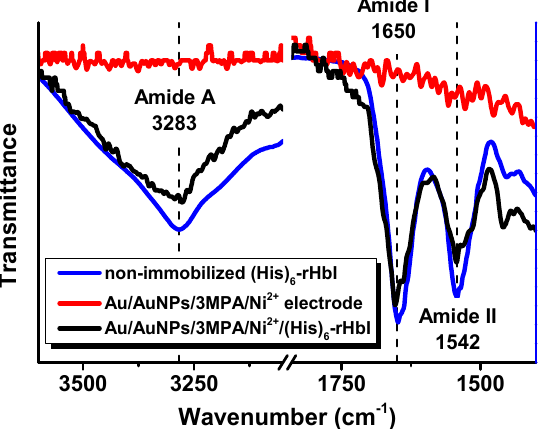
Figure 3. ATR-FTIR spectra, in amide A, and amide I and amide II regions, of non-immobilized (His) 6 -rHbI (blue line), electrode before protein immobilization, AuNPs/3MPA/Ni 2+ (red line), and electrode after protein immobilization, AuNPs/3MPA/Ni 2+ /(His) 6 -rHbI (black line).